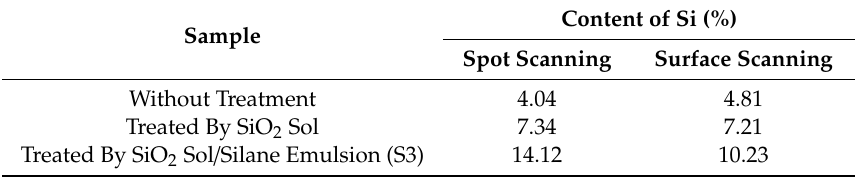
Table 6. Spot scanning and surface scanning test results in EDS